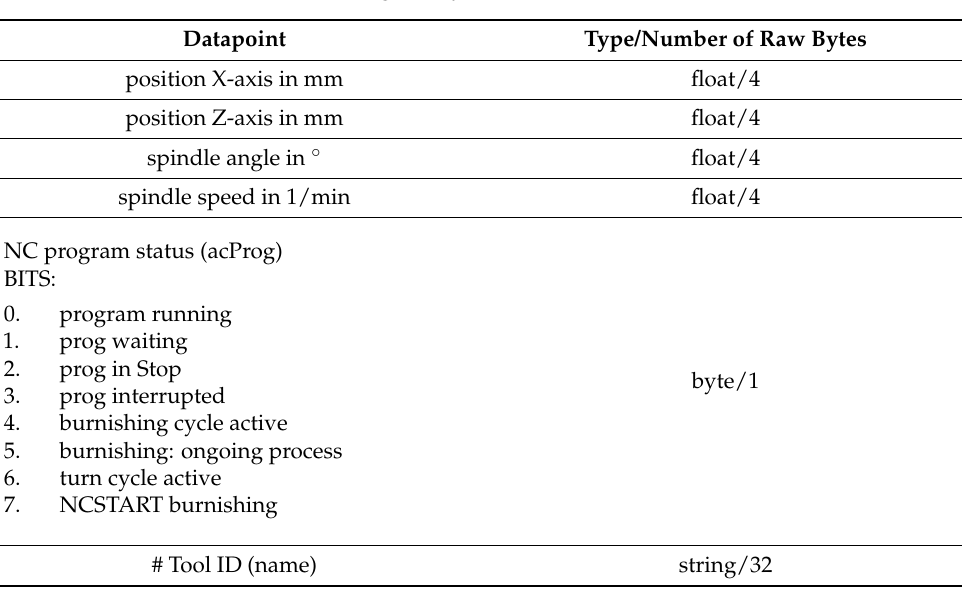
Table 5. Data from the controller to the gateway